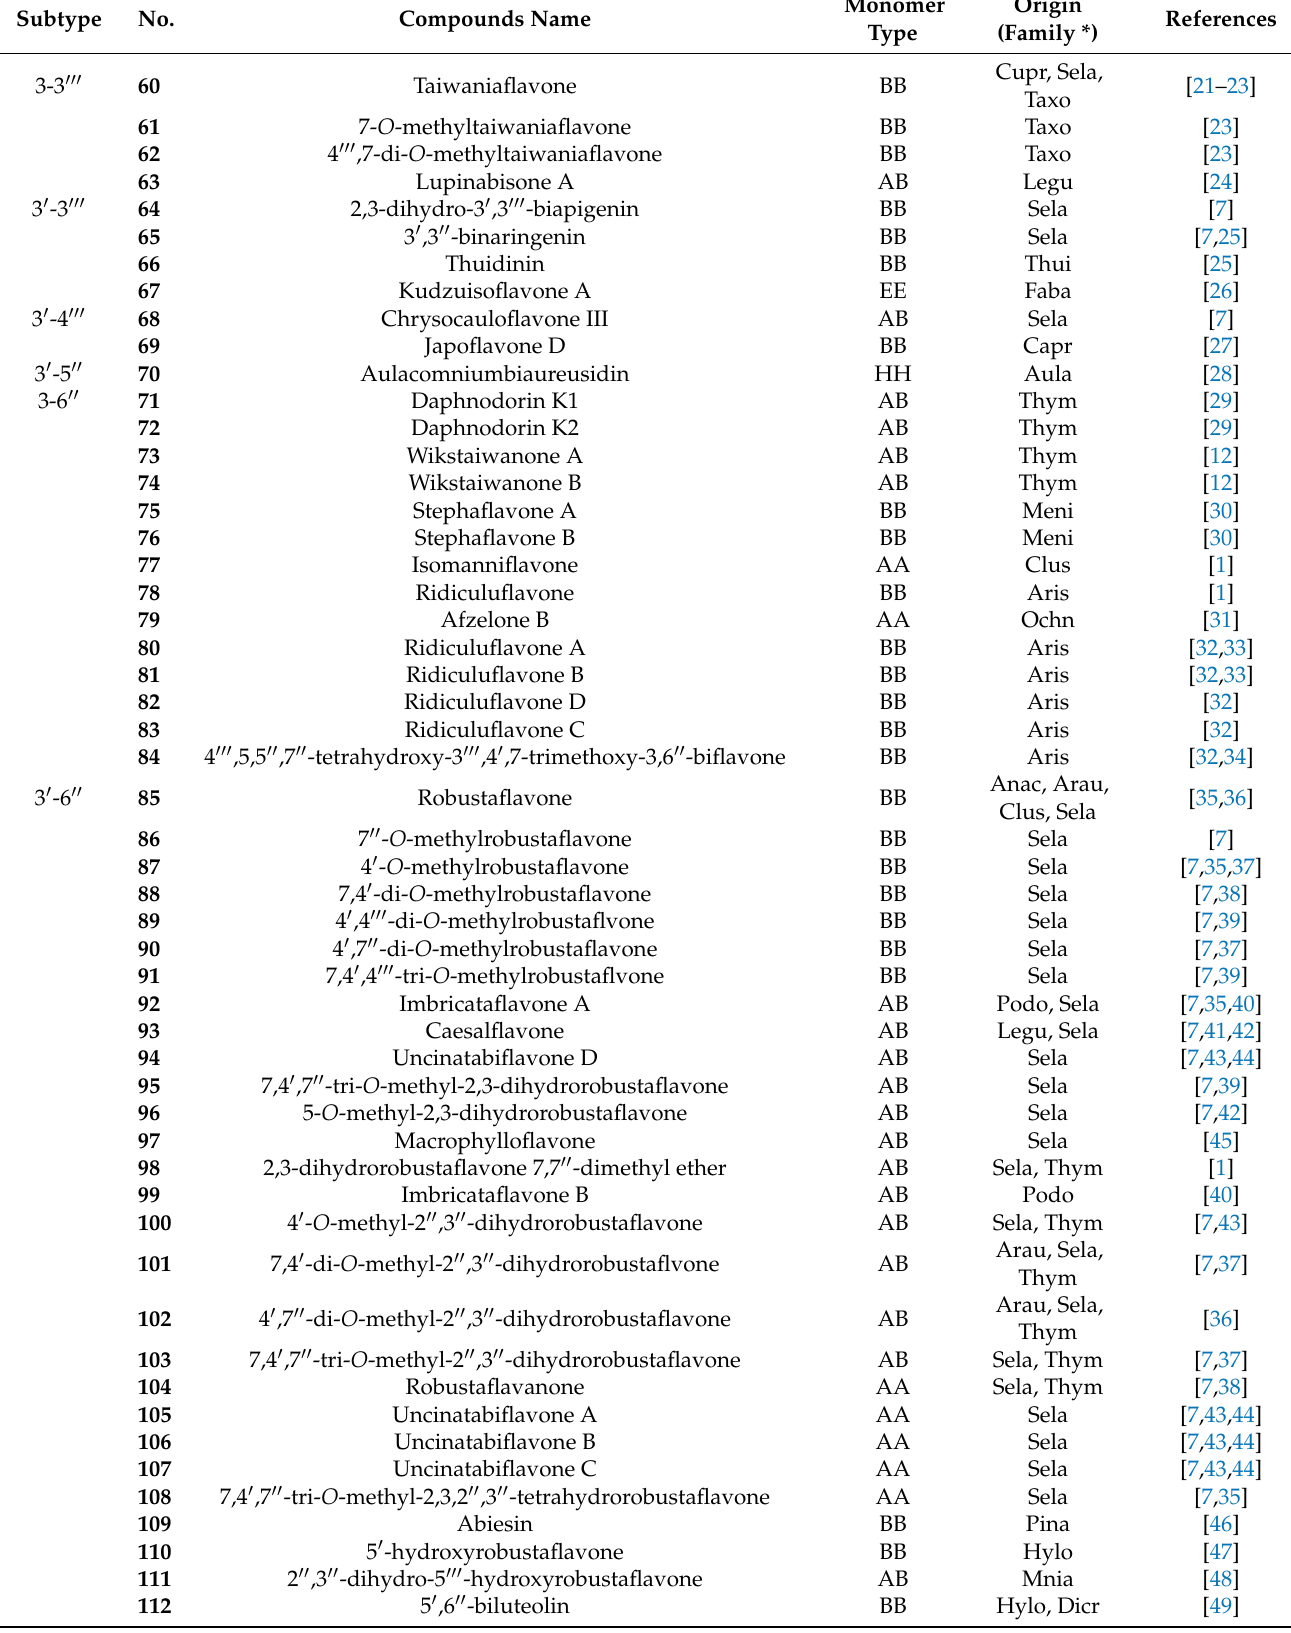
Table 2. The 3-3 (cid:48)(cid:48)(cid:48) , 3 (cid:48) -3 (cid:48)(cid:48)(cid:48) , 3 (cid:48) -4 (cid:48)(cid:48)(cid:48) , 3 (cid:48) -5 (cid:48)(cid:48) , 3-6 (cid:48)(cid:48) , 3 (cid:48) -6 (cid:48)(cid:48) , 3-7 (cid:48)(cid:48) , and 3 (cid:48) -7 (cid:48)(cid:48) subtypes of biflavonoids.